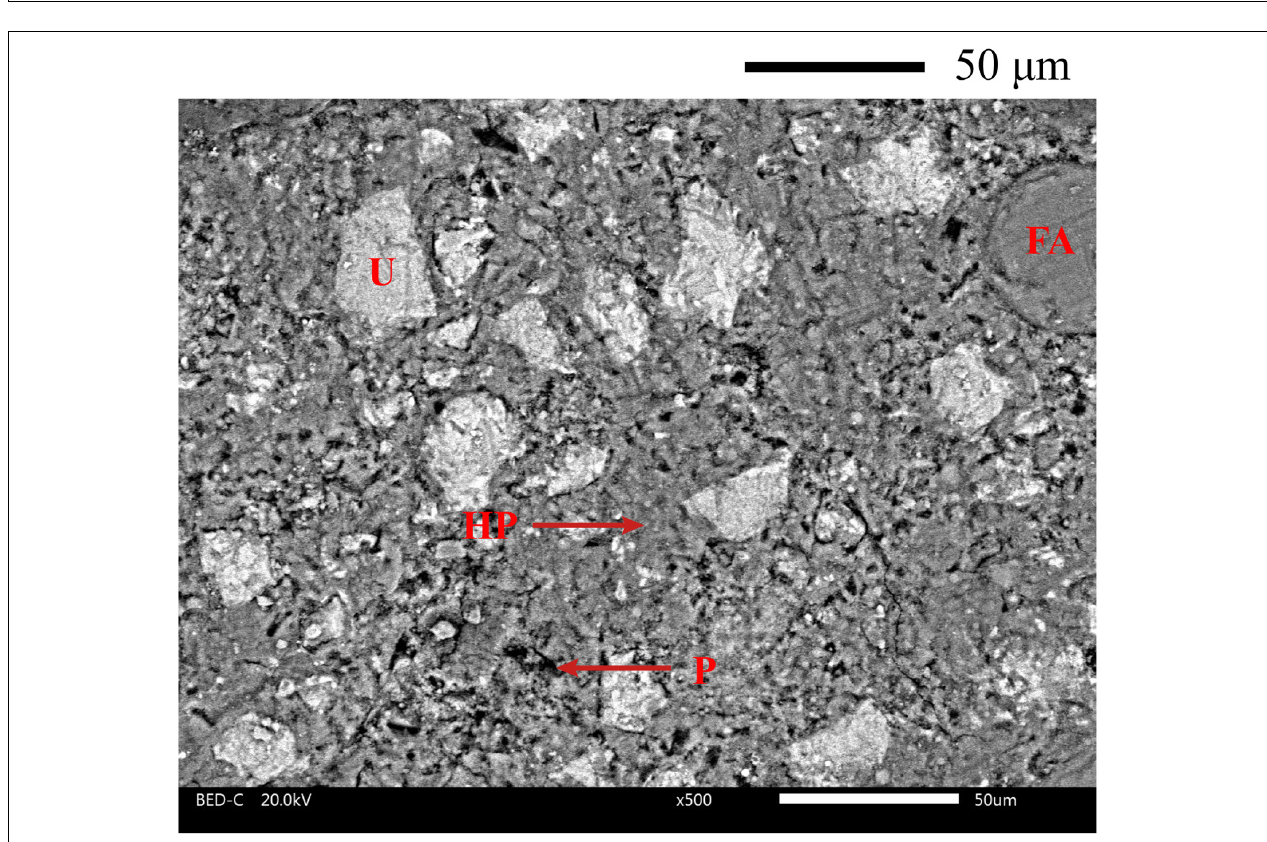
FIGURE 6 | A representative backscattered electron image. U, anhydrous; HP, hydration products; FA, fly ash; P,